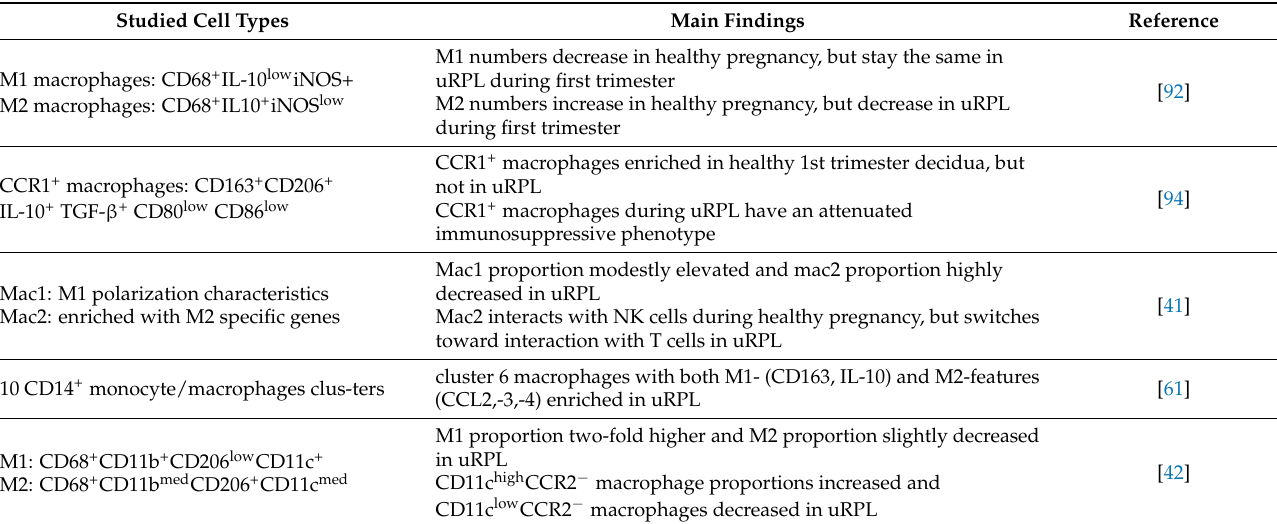
Table 2. Studies of decidual macrophages in women with